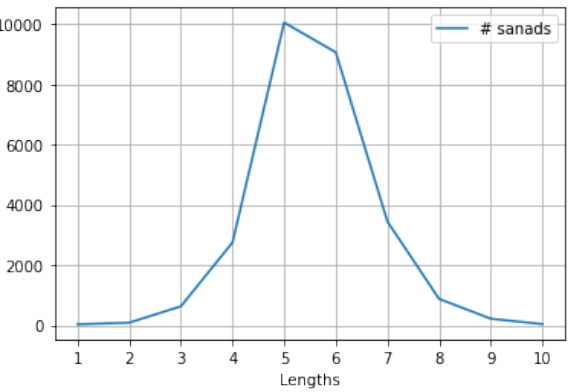
Figure 3. Distribution of sanad lengths in a set of ∼ 30 k real